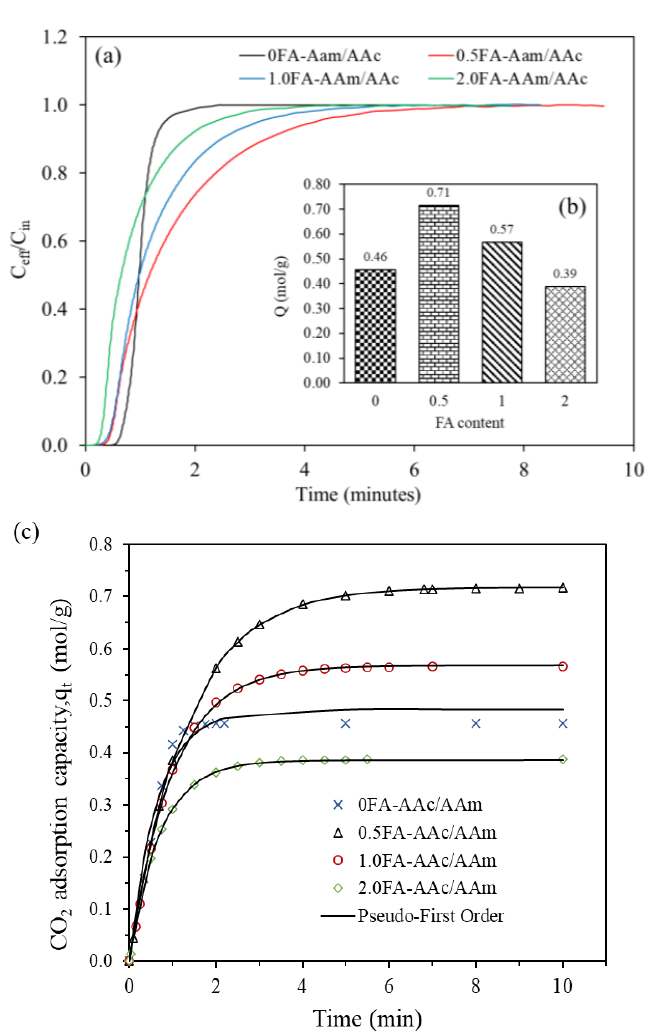
Figure 6. ( a ) Breakthrough adsorption curves, ( b ) equilibrium adsorption capacity and ( c ) pseudo- first order fitted adsorption capacity at different FA content (temperature = 30 °C, pressure = 2 bar, CO 2 flowrate = 60 mL/min).